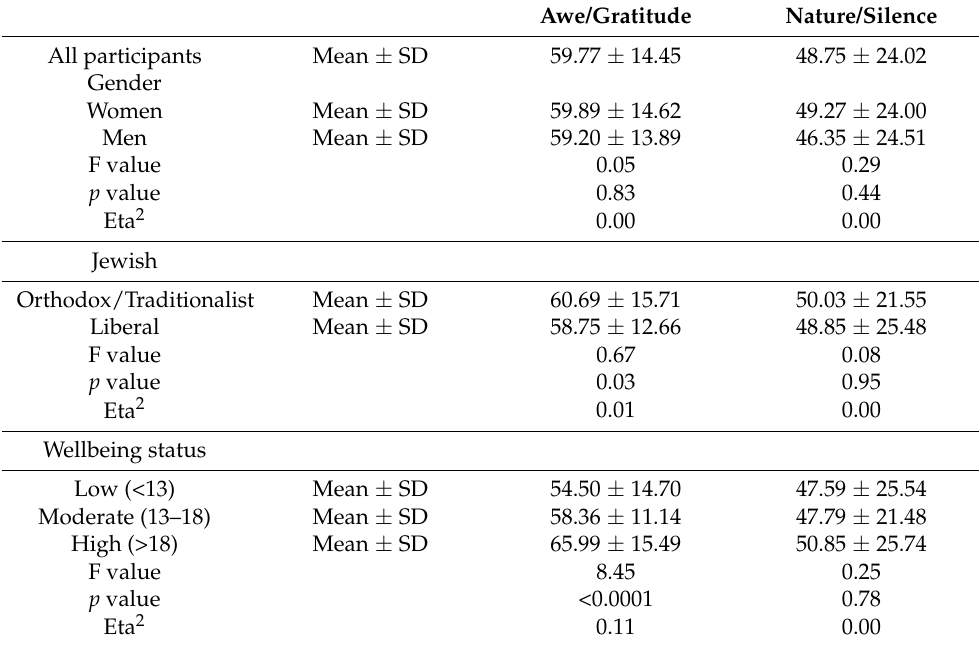
Table 3. Experience of Awe/Gratitude and Nature/Silence in